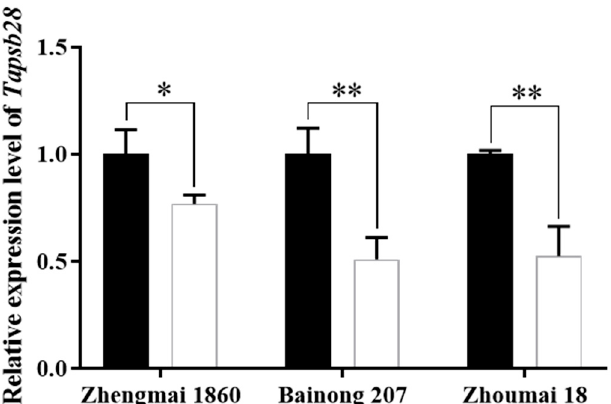
Figure 2. Relative expression of TaPsb28 in wheat leaves under drought stress. The black column represents the seedlings with normal watering, while the white column represents the seedlings after 7 d of drought treatment by ceasing watering. Three wheat cultivars, Zhengmai 1860, BaiNong 207, and Zhoumai18, were used as plant materials when two leaves were fully expanded. Data are expressed as the means ± SDs ( n = 3). “**” and “*” indicate statistically significant differences between the CK and drought treatments at p < 0.01 and 0.05, respectively.